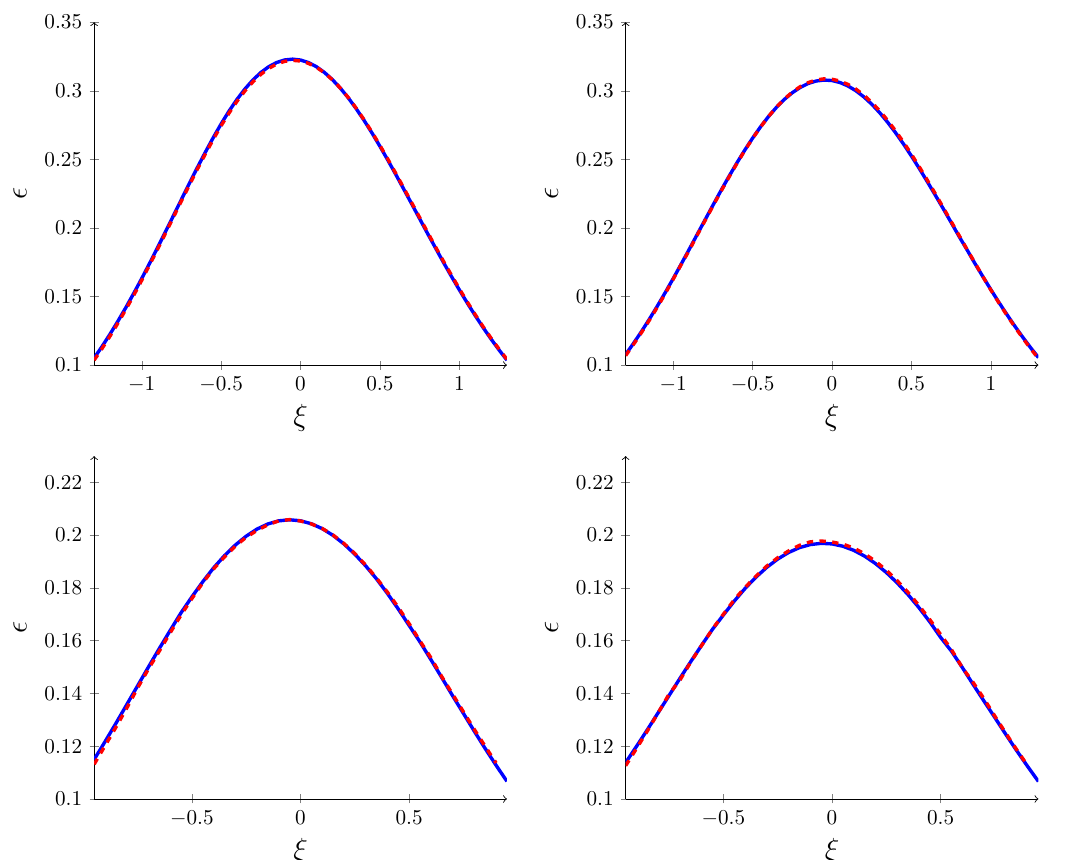
Figure 11 . The proper energy density (cid:15) as a function of rapidity (cid:24) at constant proper time (cid:28) = 2 ((cid:12)rst row) and (cid:28) = 3 (second row) for asymmetric collisions with ( w ( w ; w (cid:0) ) = (0 : 075 ; 0 : 25) (right), displayed by the solid blue curve. The overlaid red dashed curve + shows the result obtained from the improved model (4.12), with bias function a ( (cid:24) ) = (cid:0) 1 and the respective Gaussian distributions for the corresponding symmetric